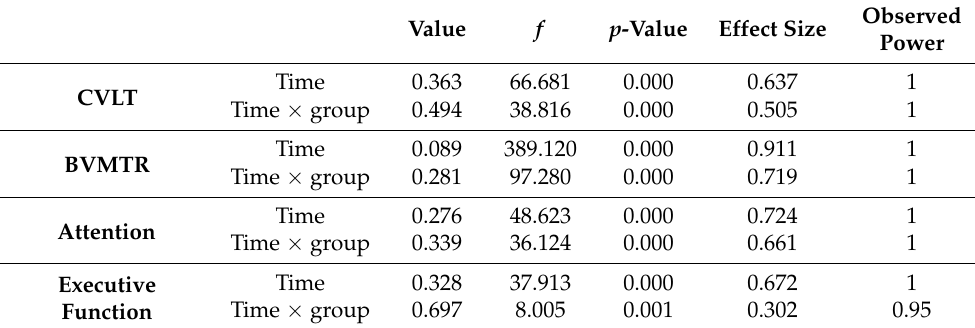
Table 4. Comparison of neuropsychological test scores for the standard care MS control group at baseline and posttreatment.